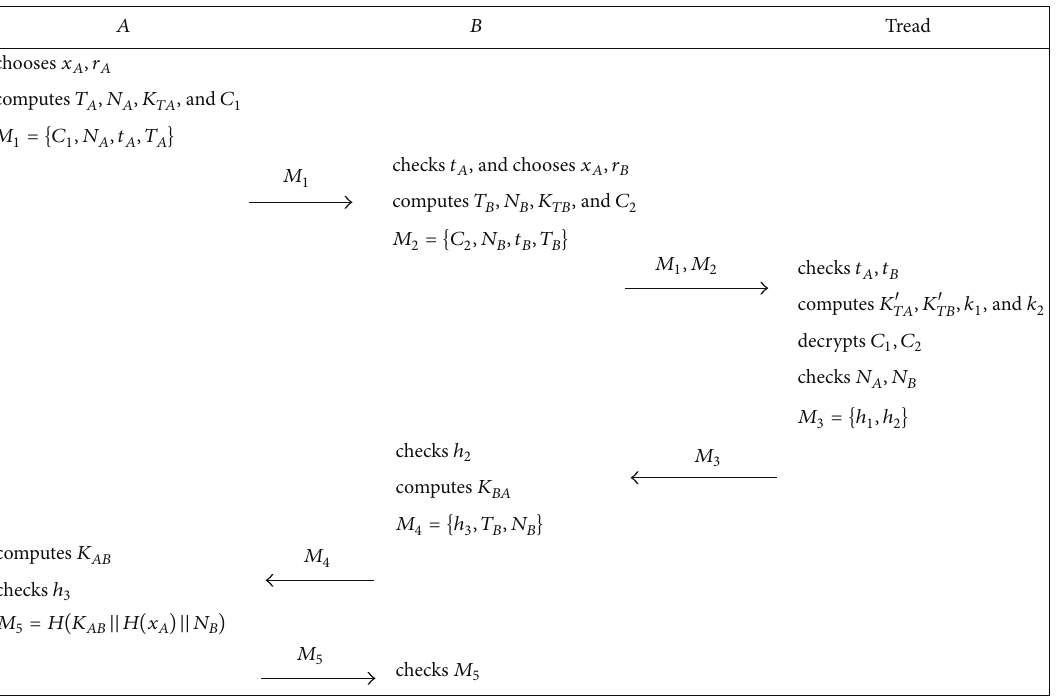
Figure 1: Process of authentication and key